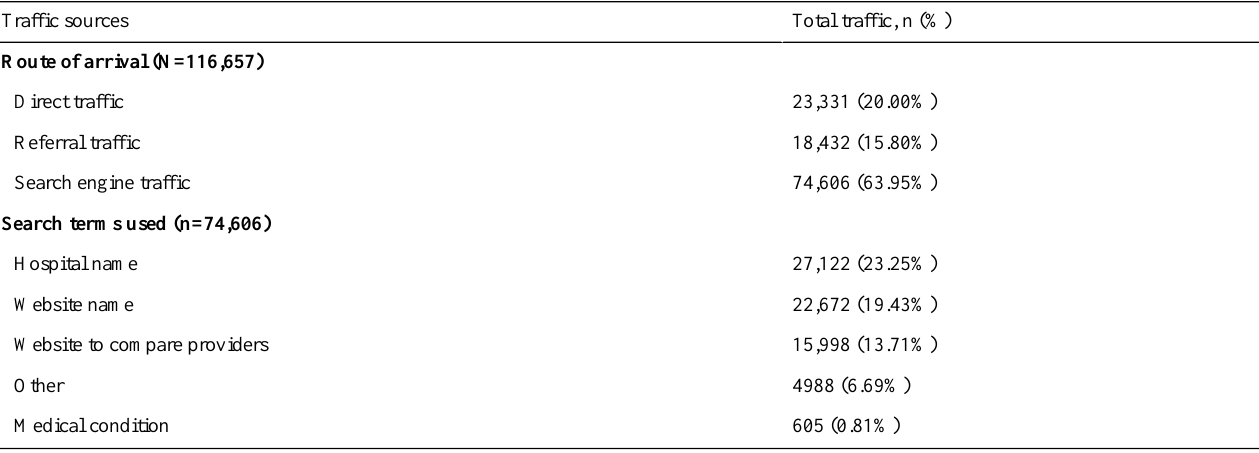
Table 2. How visitors arrived at the websites and categories of search terms used by those arriving via search engines (N=116,657 unique visitors).